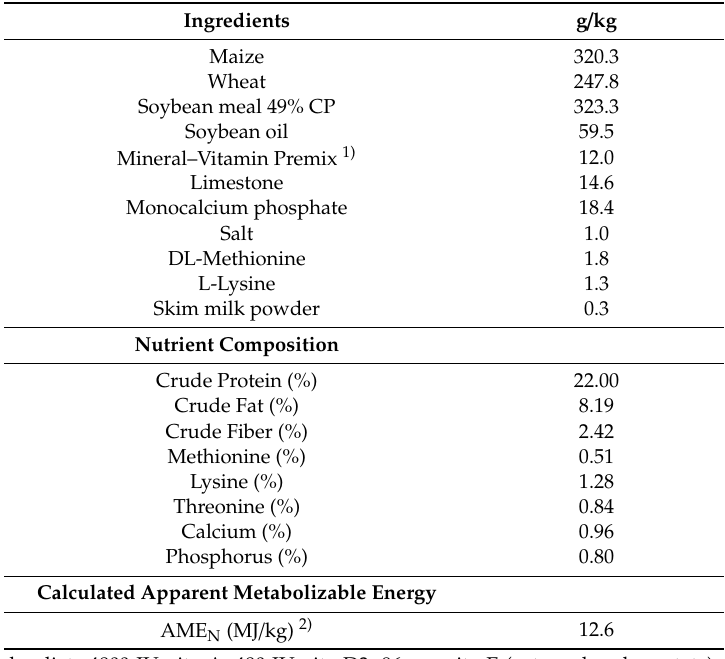
Table 1. Composition of the basal diet.